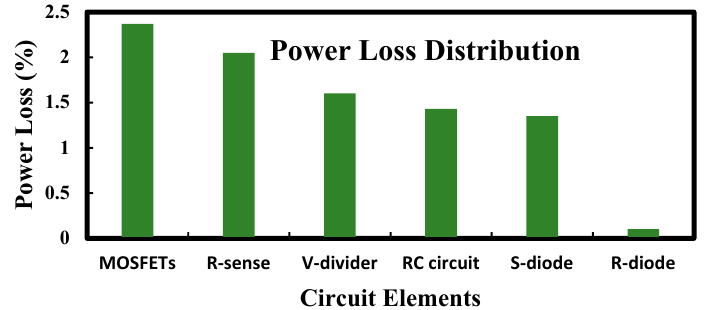
Figure 10. Power loss components in LED driver.